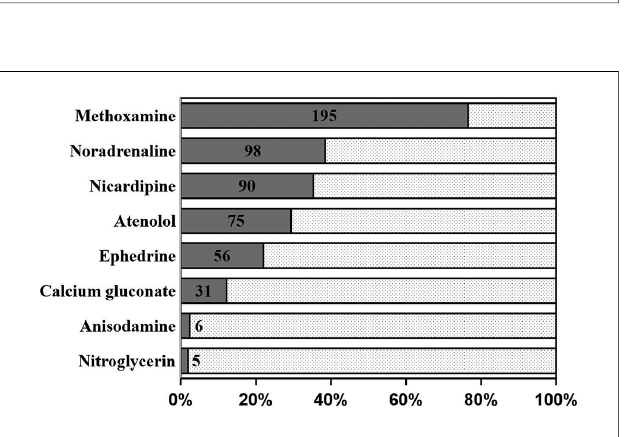
FIGURE 3 Frequency of anesthesia agents application during anesthesia maintenance period. Dexmedetomidine (236/255, 92.5%), sufentanil (233/255, 91.4%), cisatracurium (226/255, 88.6%), and propofol (222/255, 87.1%) were the most frequent anesthesia agents during maintenance